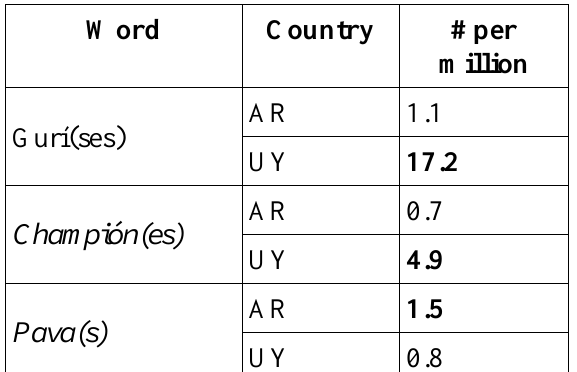
Table 2. Frequency of some lexical items in Uruguay and Argentina in words per